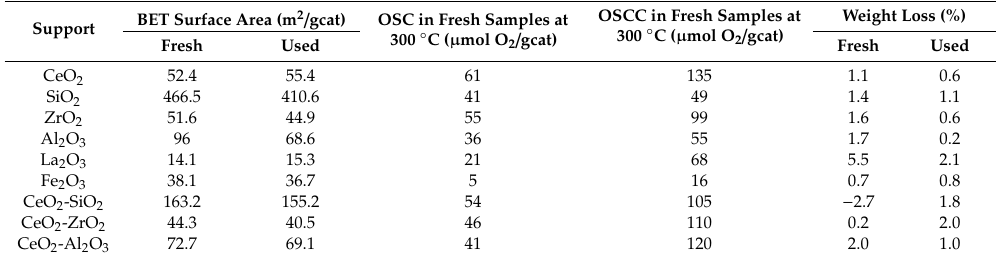
Table A1. Surface area, OSC, OSCC, and thermogravimetric analysis (TGA) results of single and dual supports.